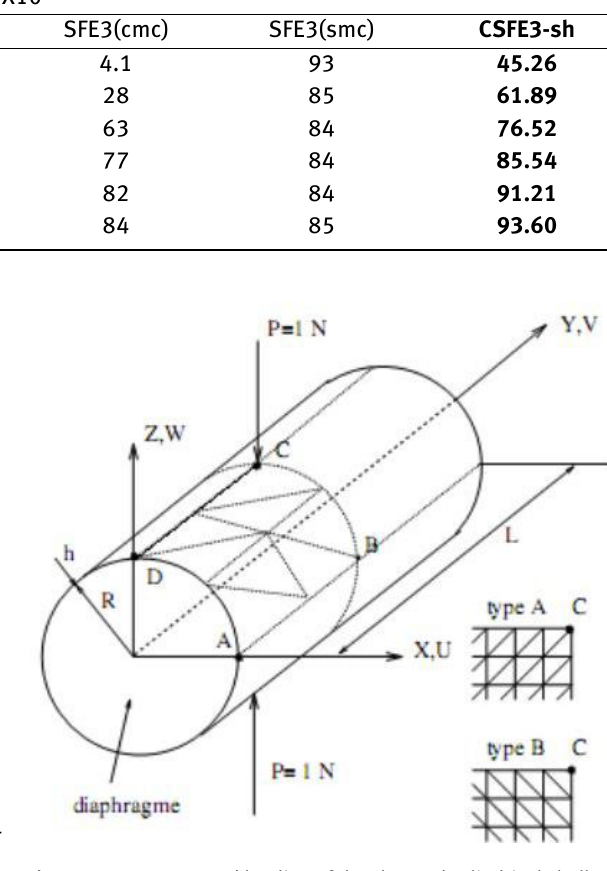
Figure 10: Geometry and loading of the clamped cylindrical shell with diaphragm